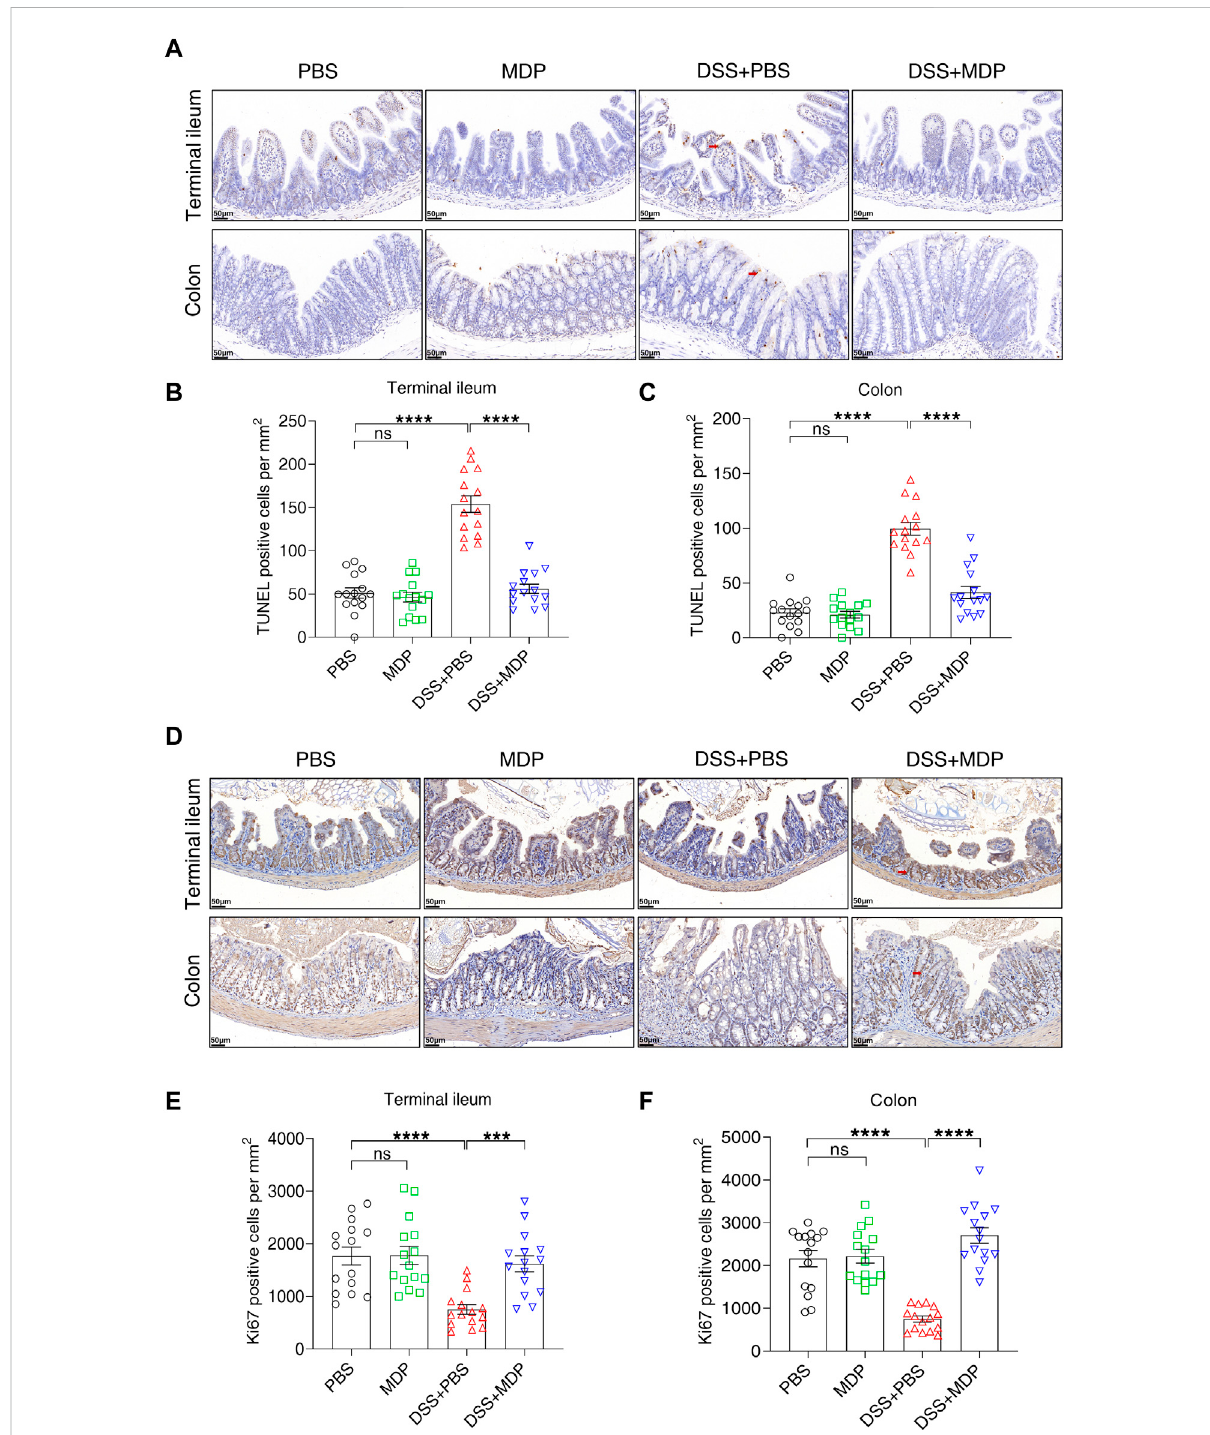
FIGURE 4 MDPdecreasestheapoptosisofintestinal epitheliuminDSS-induced mice. (A) RepresentativeimagesofTUNEL stainingfor terminalileumand colon tissues inPBS,MDP, DSS+ PBS, and DSS+ MDP group mice (n= 3, each group), respectively. scale bars:50 μ m.Red arrowsindicated positive cells. (B,C) Quanti fi cationofTUNELpositive cellspermm 2 interminalileumandcolon(n=3,eachgroup),respectively. (D) Representative imagesof Ki67 staining for terminal ileum and colon tissues in PBS, MDP, DSS + PBS, and DSS + MDP group mice (n = 3, each group), respectively. scale bars: 50 μ m. Red arrows indicated positive cells. (E,F) Quanti fi cation of Ki67 positive cells per mm 2 in terminal ileum and colon (n = 3, each group), respectively. Data were expressed as mean ± SEM. *** p < 0.001, **** p < 0.0001, ns, not signi fi cant, One-way